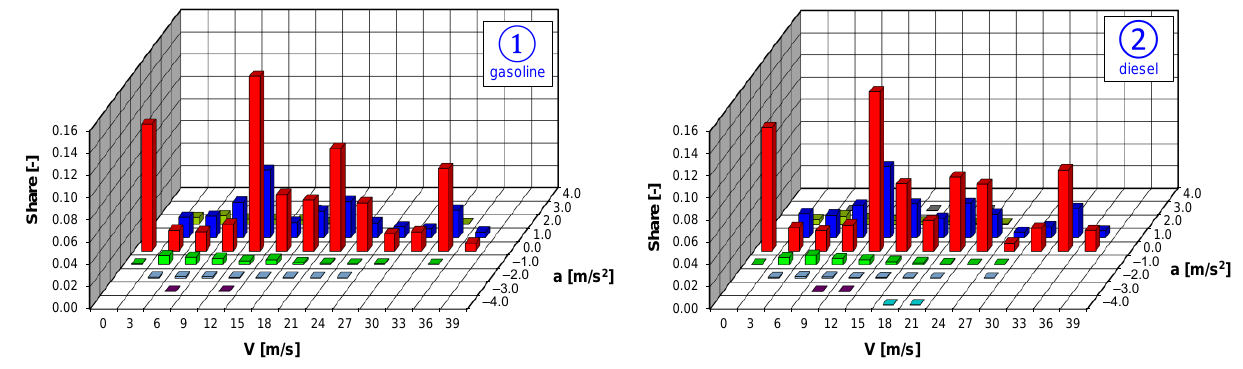
Figure 6. Comparison of the share of the vehicle’s operation in the velocity– acceleration coordi- nates for vehicles 1 and 2; 1 — gasoline, 2 — diesel.